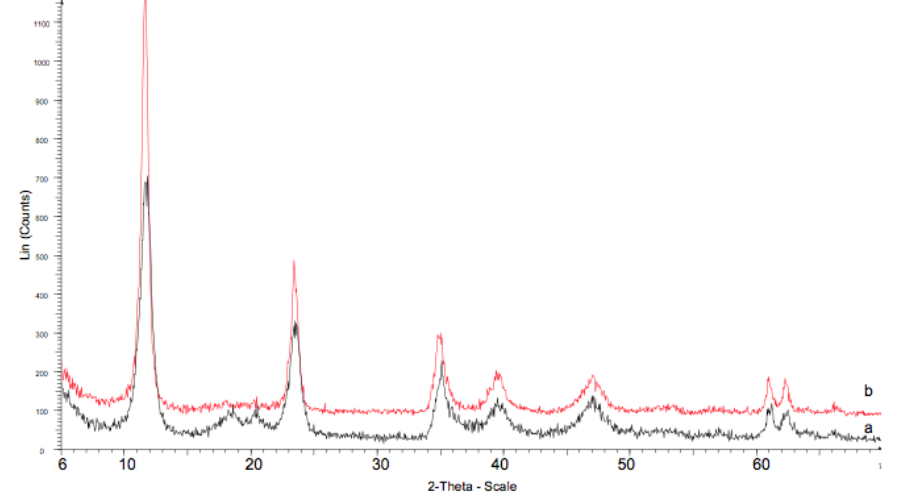
Figure 6. XRD pattern of the catalyst HTMgAl3 a) before, and b) after reaction.